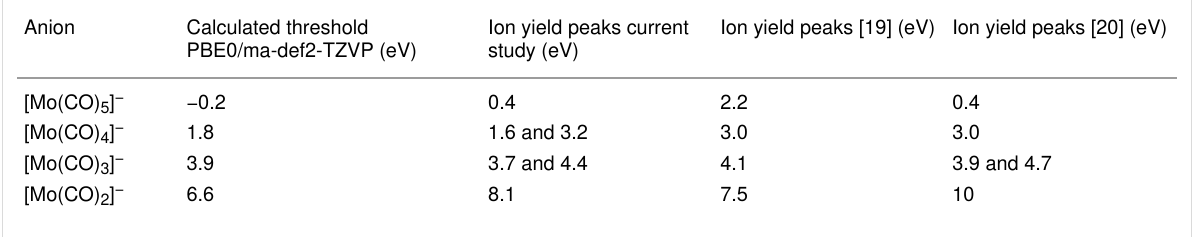
Table 1: Experimentally determined peak positions for fragments observed in dissociative electron attachment to Mo(CO) 6 , compared to literature values [19,20] and the respective thermochemical threshold values calculated at PBE0/ma-def2-TZVP level of theory. Anion Calculated threshold Ion yield peaks current PBE0/ma-def2-TZVP (eV) study